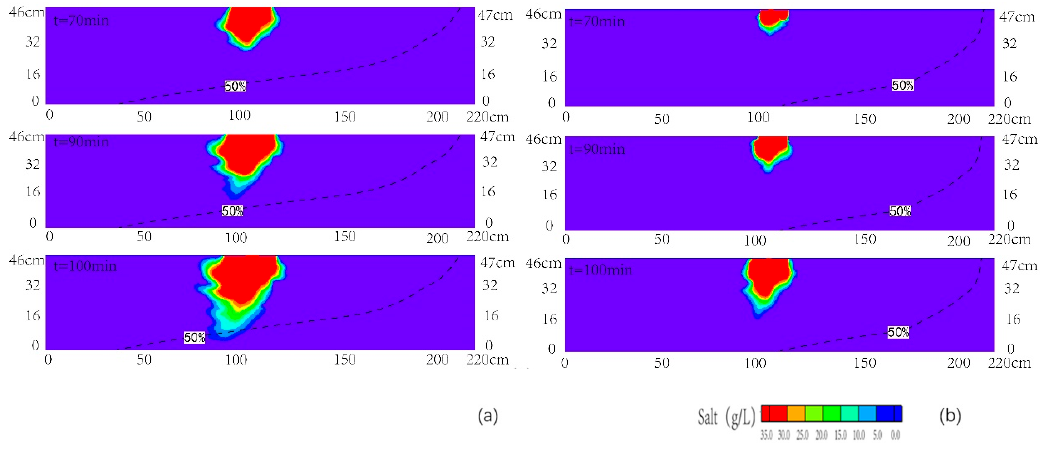
Figure 7. Simulated spatial saltwater contamination concentration distributions for ( a ) increasing hydraulic conductivities and ( b ) decreasing hydraulic conductivities at different times. The black dashed line denoted the contour line with the concentration of 0.5 time of seawater